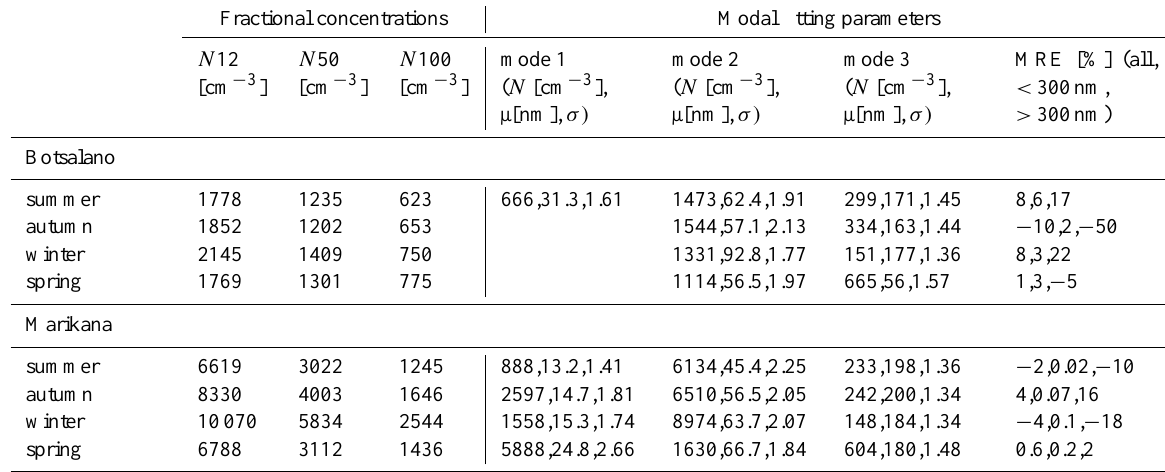
Table 4. Seasonal median distribution parameters for Botsalano and Marikana. Summer is December to February, autumn is March to May, winter is June to August and spring is September to November. Fractional